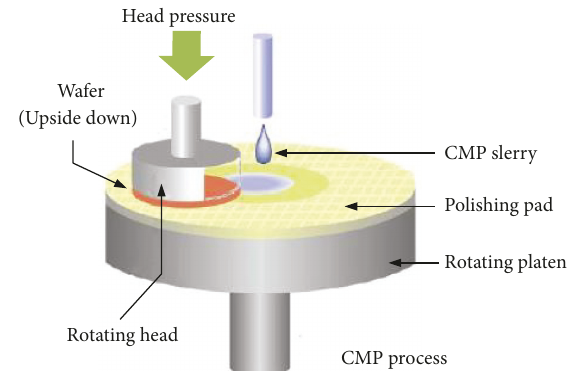
Figure 31: Chemical mechanical planarization principle.